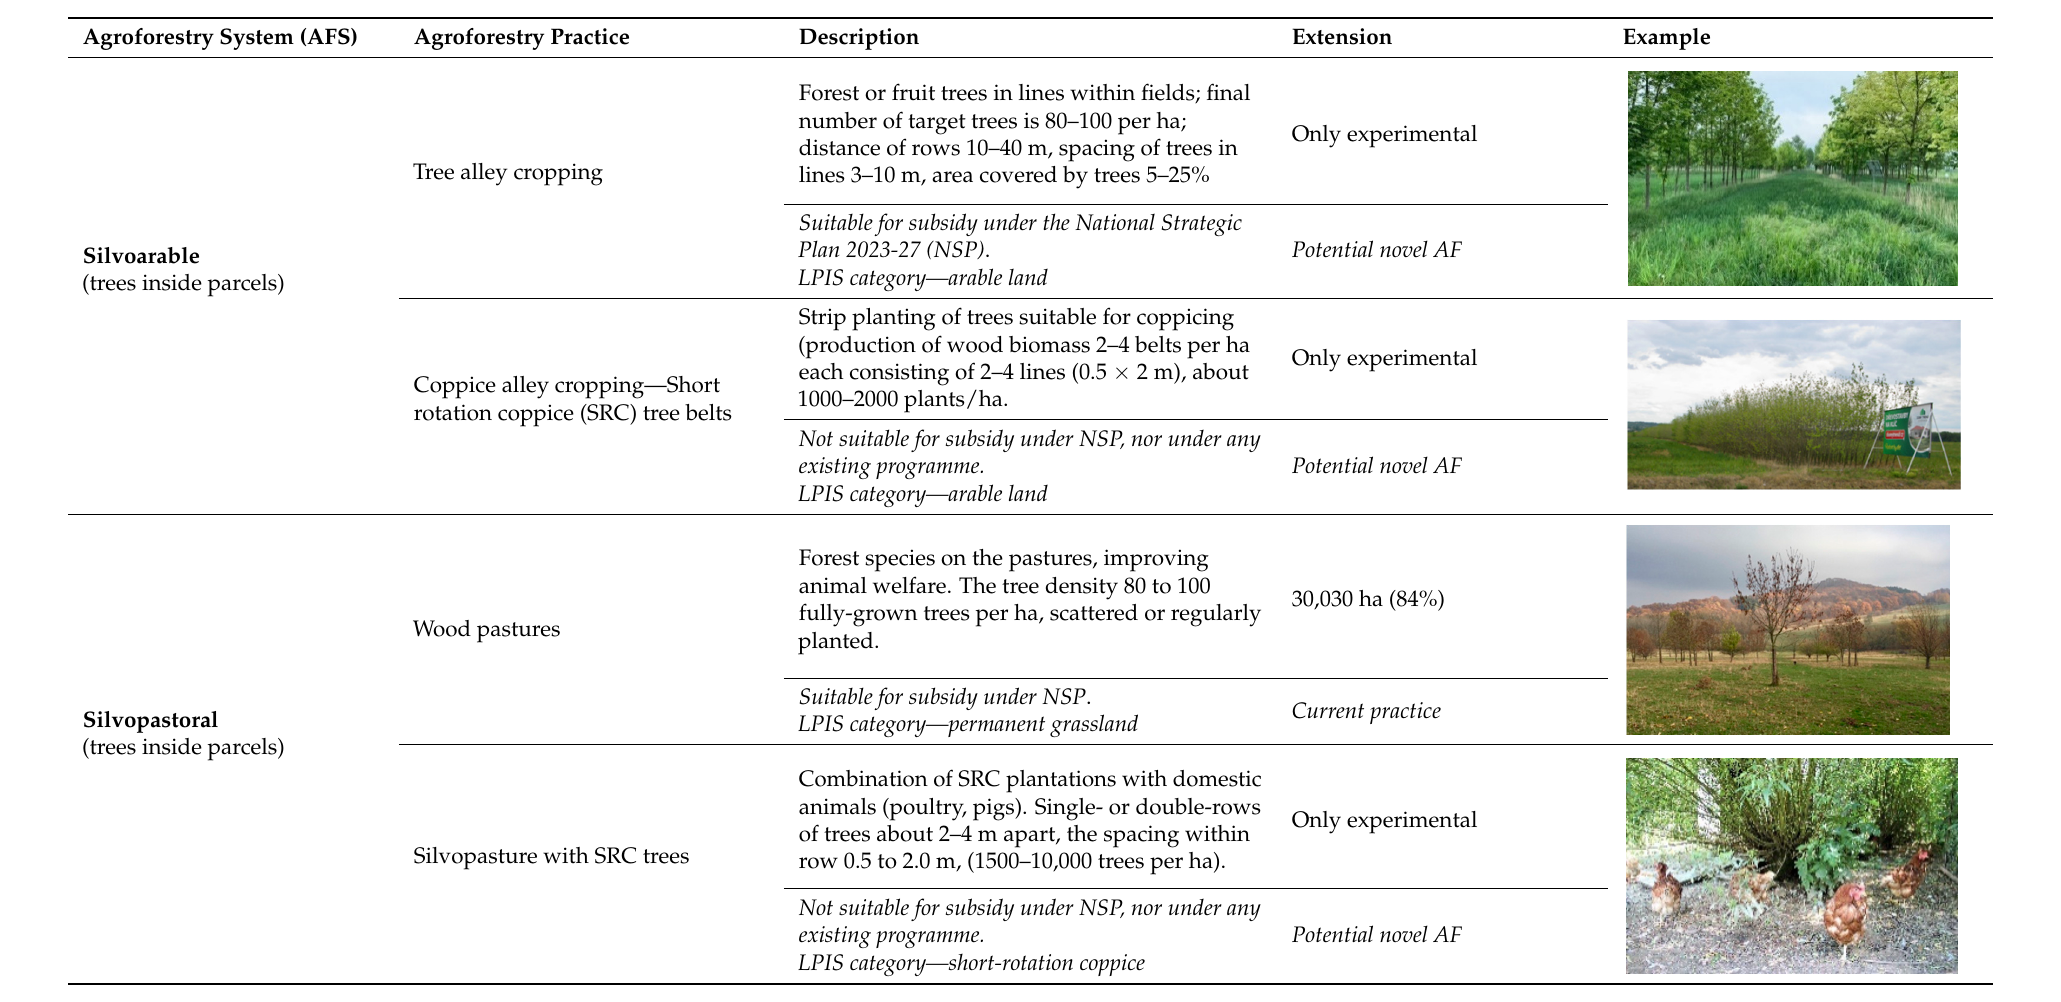
Table 3. Classification, description, support and extent of agroforestry (AF) in the Czech Republic.